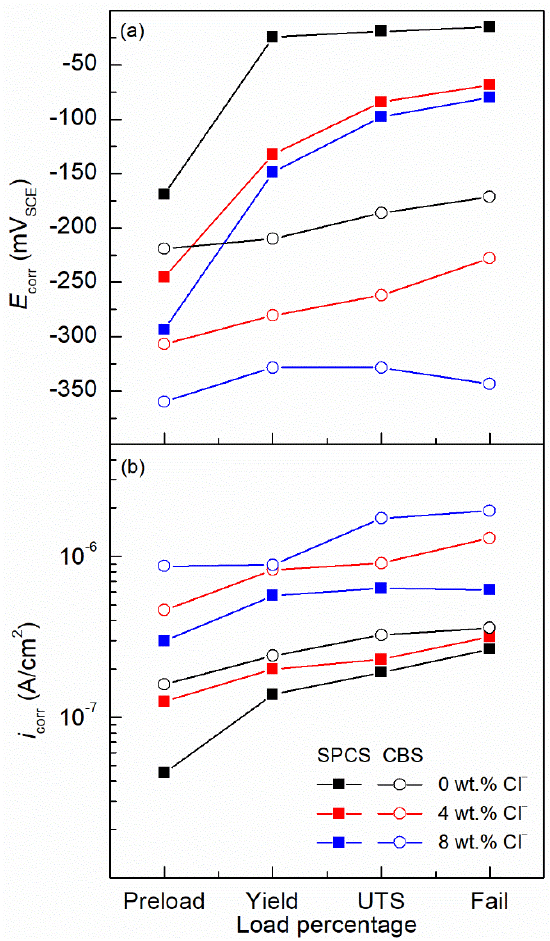
Figure 3. Linear polarization resistance measurements of UNS S32205 reinforcement during slow strain rate test (SSRT): ( a ) E corr , and ( b ) i corr .